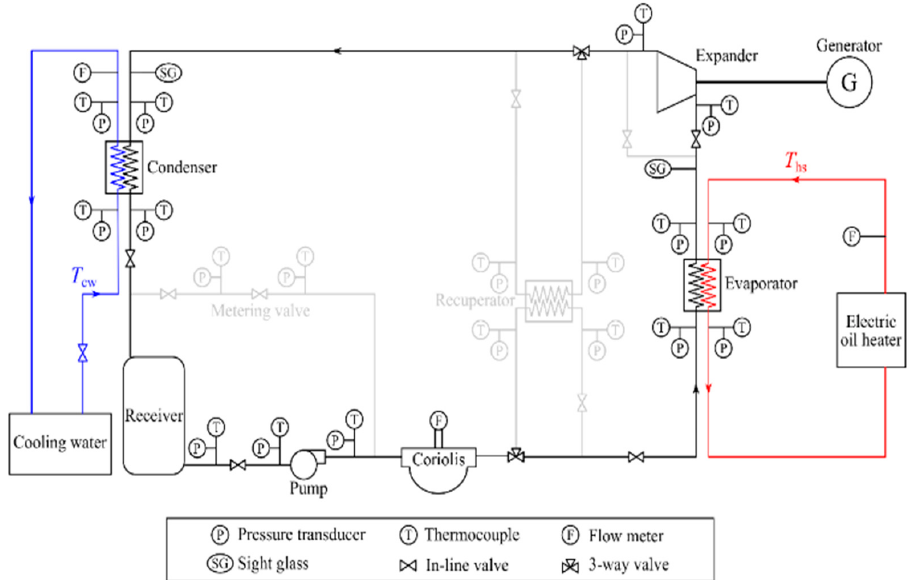
Figure 2. Piping and instrumentation diagram of ORC (organic Rankine cycle) testing facility (taken from [32]).